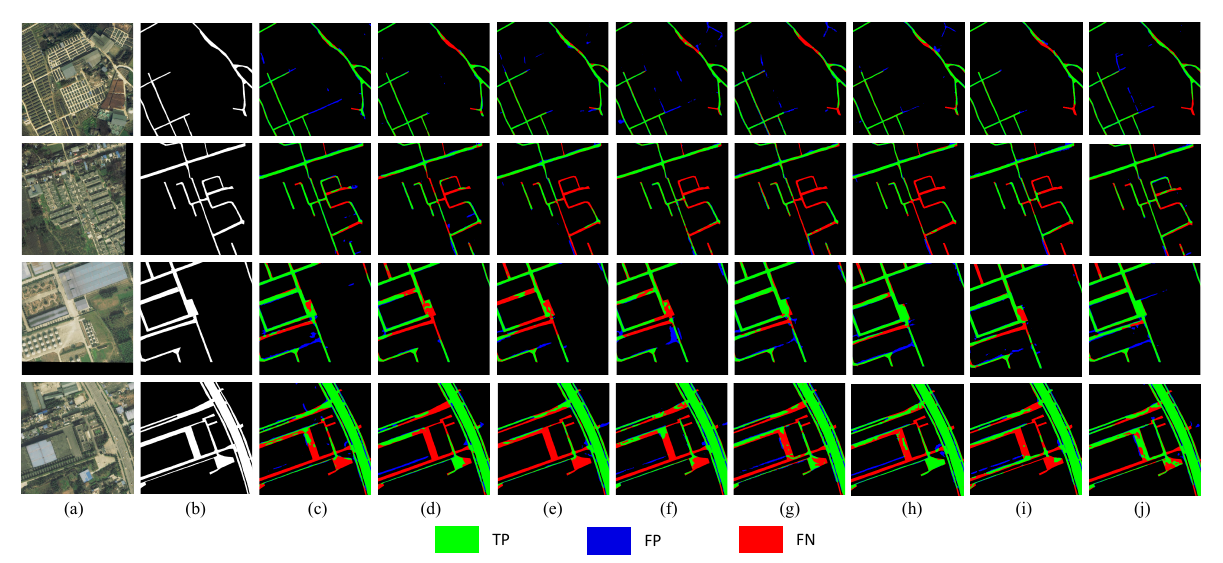
Figure 10. Results of road extraction on the Chongzhou dataset. ( a ) RGB satellite imagery. ( b ) Ground truth. ( c ) LinkNet. ( d ) D-LinkNet. ( e ) HRNet. ( f ) CCNet. ( g ) DANet. ( h ) DBRANet. ( i ) NL-LinkNet. ( j )